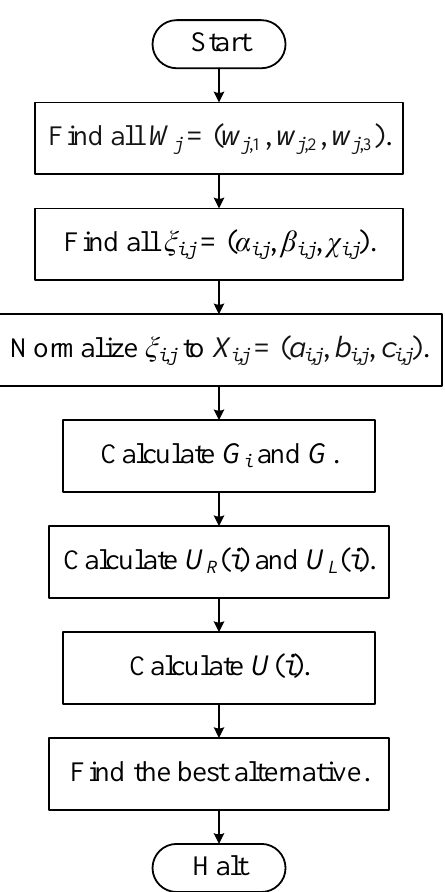
Figure 5. Flowchart of the inverse function-based fuzzy ranking (IFR).